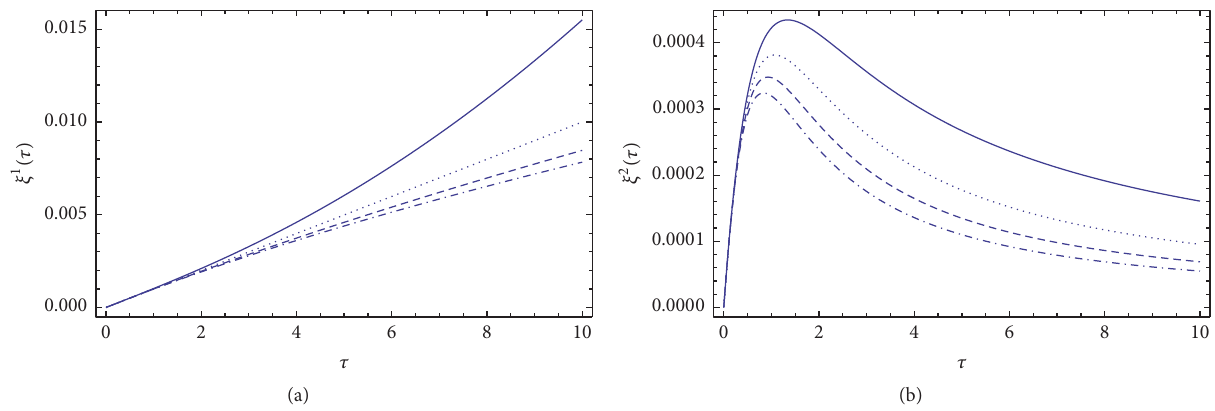
Figure 5: Time variations of the deviation vector components 𝜉 1 (a) and 𝜉 2 (b) for a Universe filled with a scalar field with exponential potential, for different values of the parameter 𝜆 : 𝜆 = −1 (solid curve), 𝜆 = −√2 (dotted curve), 𝜆 = −√3 (dashed curve), and 𝜆 = −2 (dashed dotted curve).